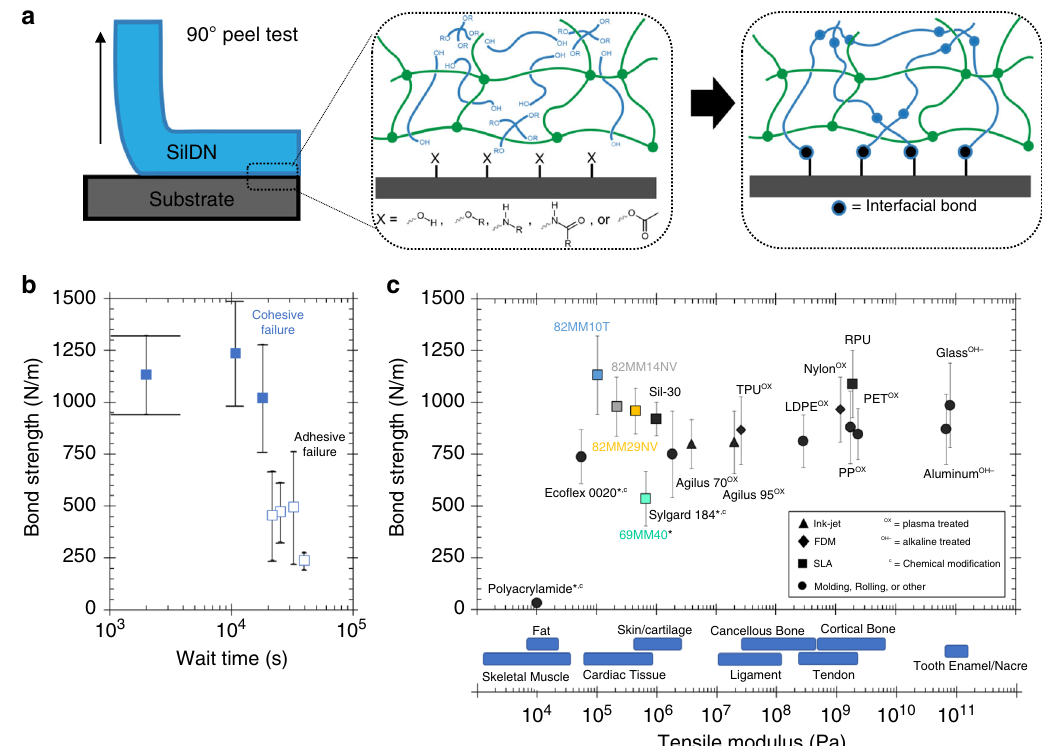
Fig. 3 Post-print bonding of SilDNs. a Overview of 90° Pee Test and proposed schematic of bonding process. Numerous condensable groups ( X = – OH, – OR, – NHR, – NHR[C = O]R, – O[C = O]CH 3 ) can participate in the proposed interfacial bonding reaction. b Bond strength vs. wait time for 82%MM10T bonded to itself. Open symbols denote adhesive failure, closed symbols denote cohesive failure. The height of the error bars corresponds to the SD and the width of error bars denotes uncertainty in wait time ( N > 7). c Bond strength for 82%MM10T to numerous substrates ( N > 7 for each material combination). Materials* whose ultimate strength is below that of the SilDN display a lower bond strength as a result of cohesive failure through the substrate itself. Superscripts denote any modi fi cations to the substrate that improved bondability. Triangle symbols represent ink-jetted samples, diamonds represent FDM printed samples, squares represent SLA printed samples, and circles represent conventionally fabricated (molding, rolling, or other)